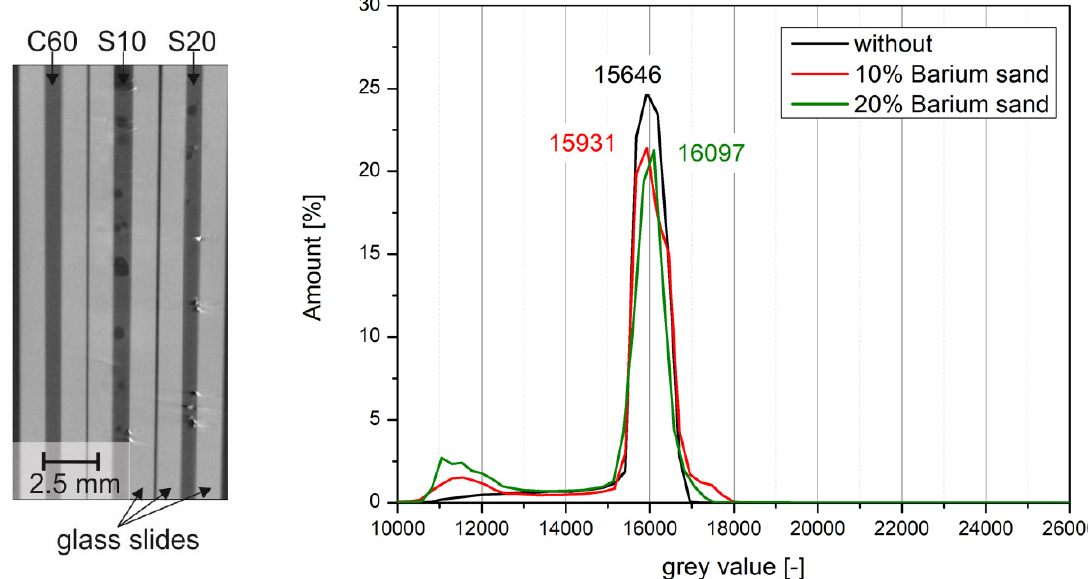
Figure 12. Cross-section through the CT scan of the bitumen samples without and with 10 wt% and 20 wt% barium sulfate sand ( left ) and evaluation of the gray scale histograms for the different dosages ( right ).